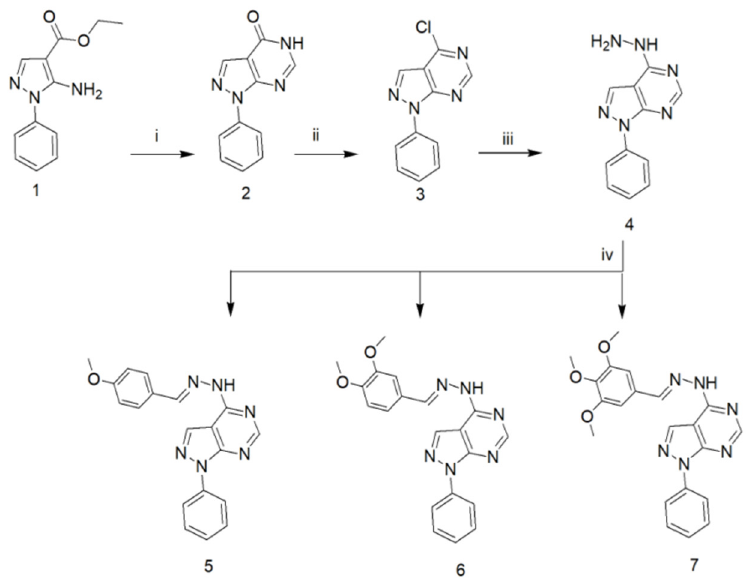
Figure 2. Synthetic pathway for the synthesis of the target compounds 5 – 7 ; reagents and reaction conditions: i: HCONH 2 , reflux, 10 h; ii: POCl 3 , reflux, 4 h; iii: NH 2 NH 2 , EtOH, reflux, 6 h; iv: ArCHO, EtOH, reflux, 3 h.